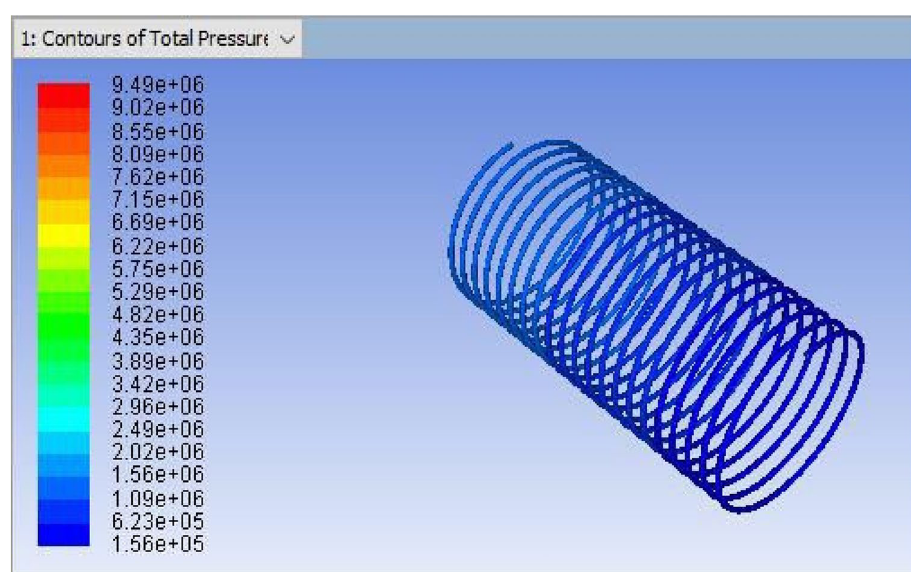
Figure 7. CFD result for a total pressure of Coil-1 (3352.8